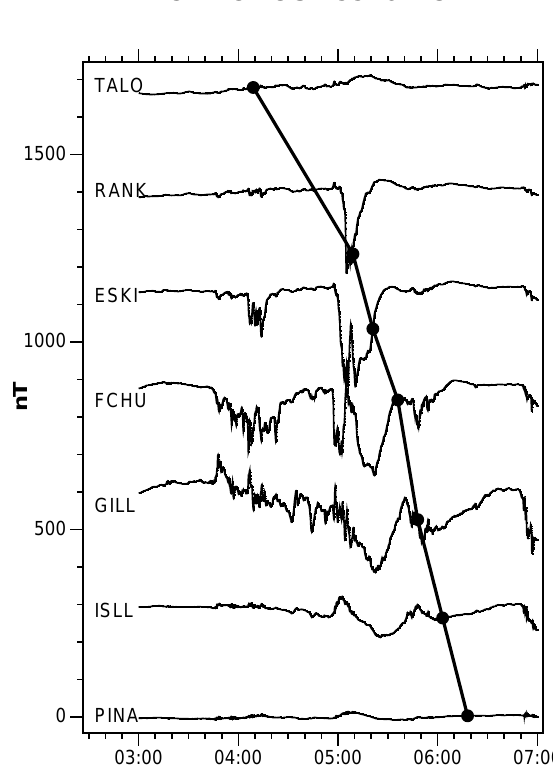
Fig. 7. Stacked plot of CANOPUS magnetogram X components (northward components) for 25 April 1997. Between 5–6UT a negative bay of a substorm is most strongly seen in Rankin Inlet (RANK), Eskimo Point (ESKI), Fort Churchill (FCHU) and Gillam (GILL). The times when Polar intersects the ILAT circle of each magnetometer are shown as dots and connected by a